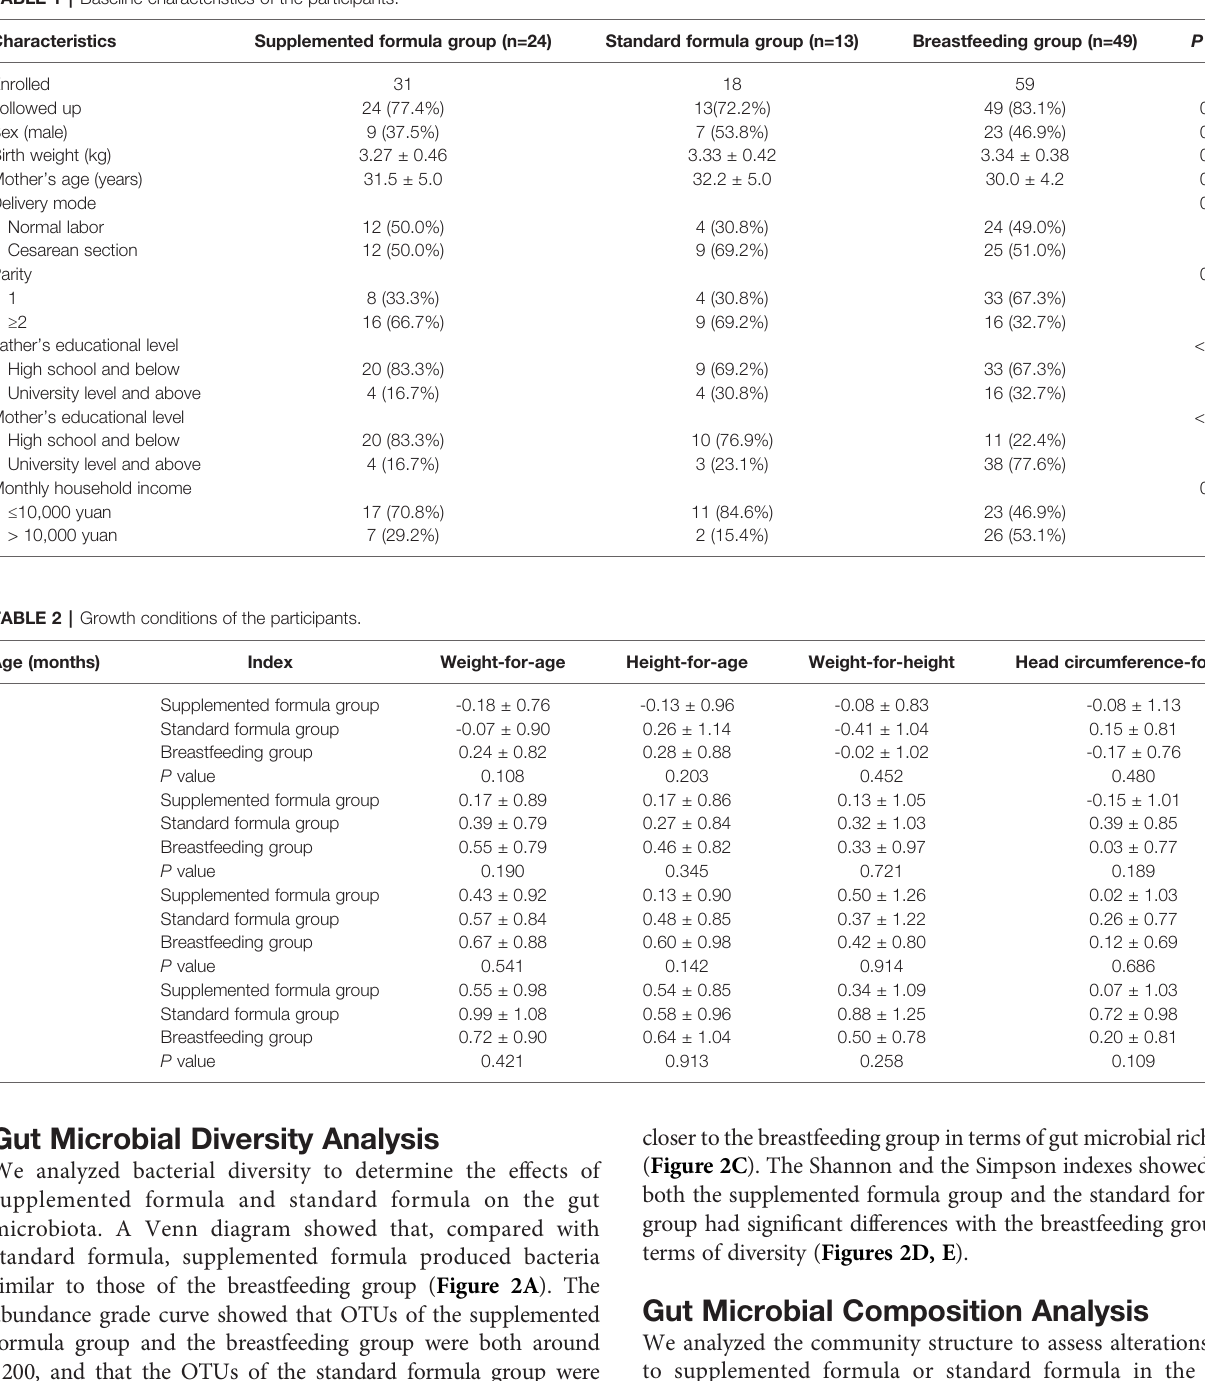
TABLE 1 | Baseline characteristics of the